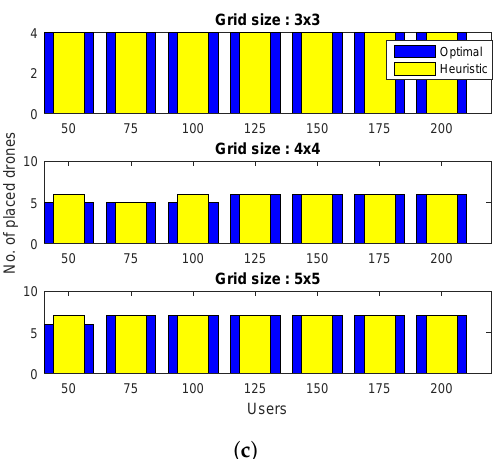
Figure 3. Comparison of proposed heuristic with the optimal algorithm for β = 0.8 and different grid sizes in terms of: ( a ) The total number of connected users, ( b ) total number of placed drones, and ( c ) the utility value, that is, the ratio of the total number of placed drones to the total number of connected users.